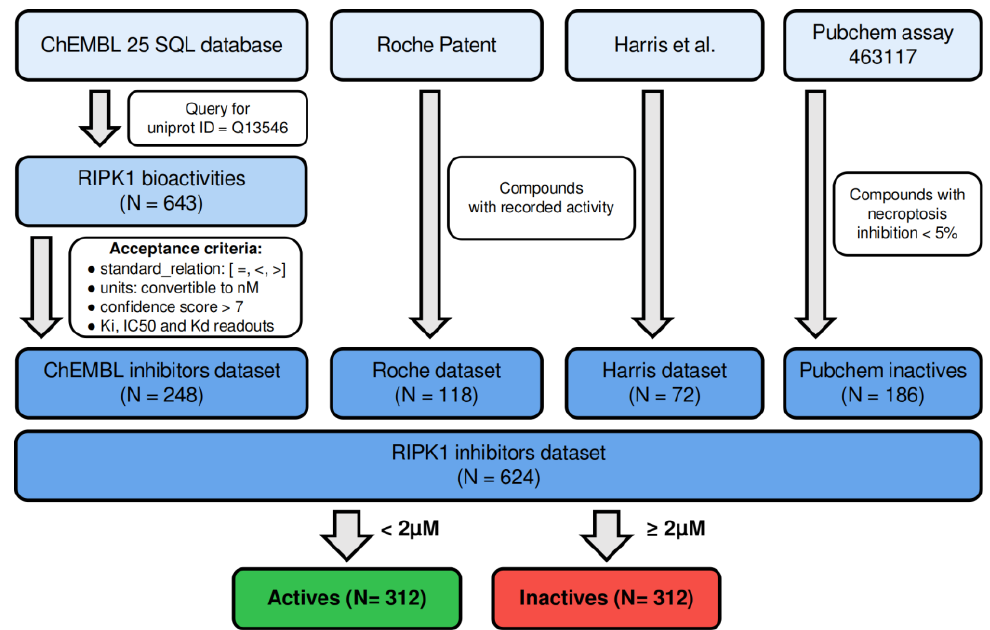
Figure 1. Overview of the data assembly workflow used to produce the dataset of RIPK1 inhibitors that was used in this work [13].